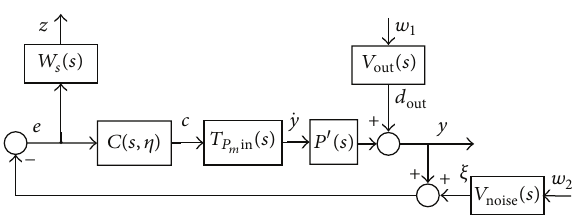
Figure 7: External loop optimization